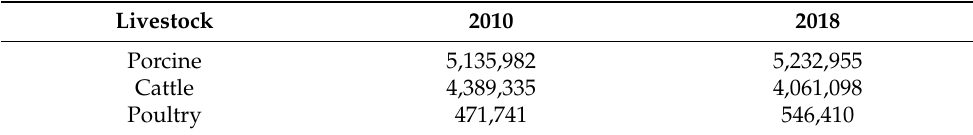
Table 5. Tons of meat co-products and offal in the EU(28) in 2010 and 2018, based on [102,109].